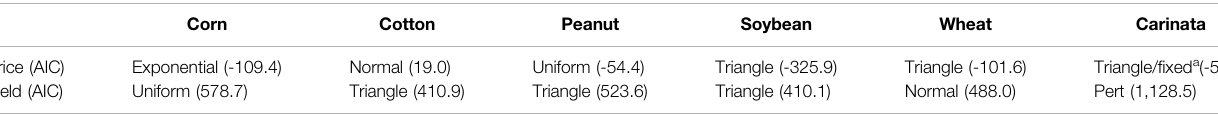
TABLE 5 | Fitted distribution forms for the price and yield of different